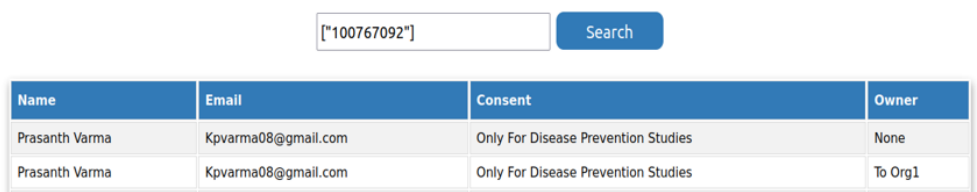
Figure 10. Reading user ’ s consent details from the network.